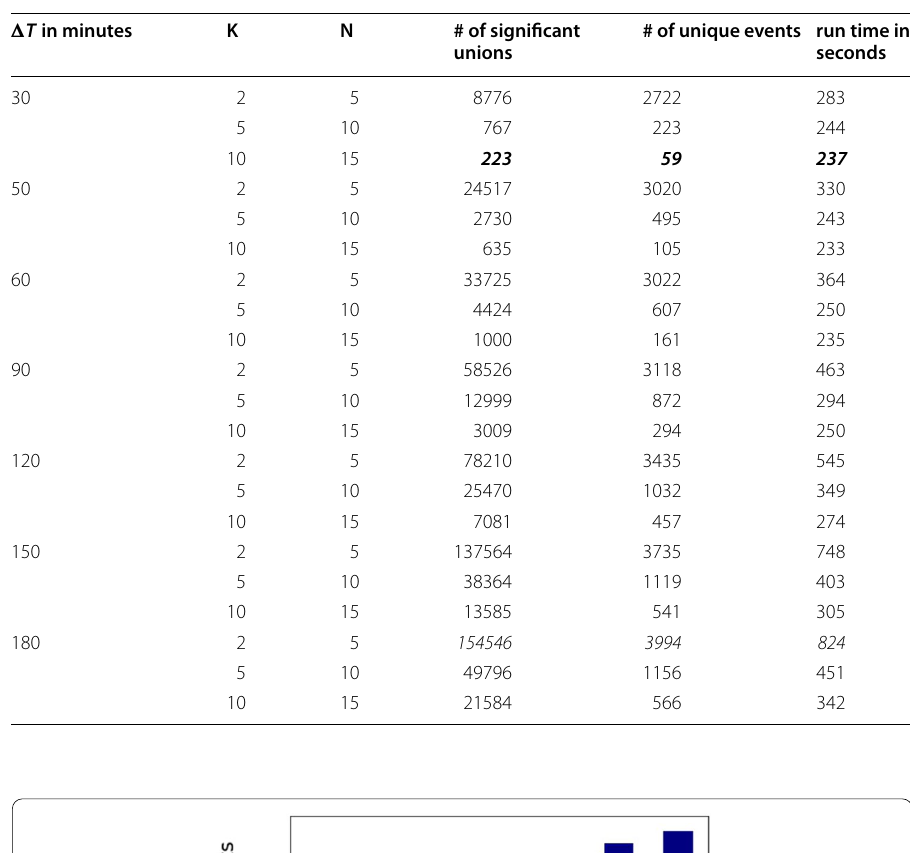
Table 12 Clustering-based event detection: the impact of parameter selection on the final detected events